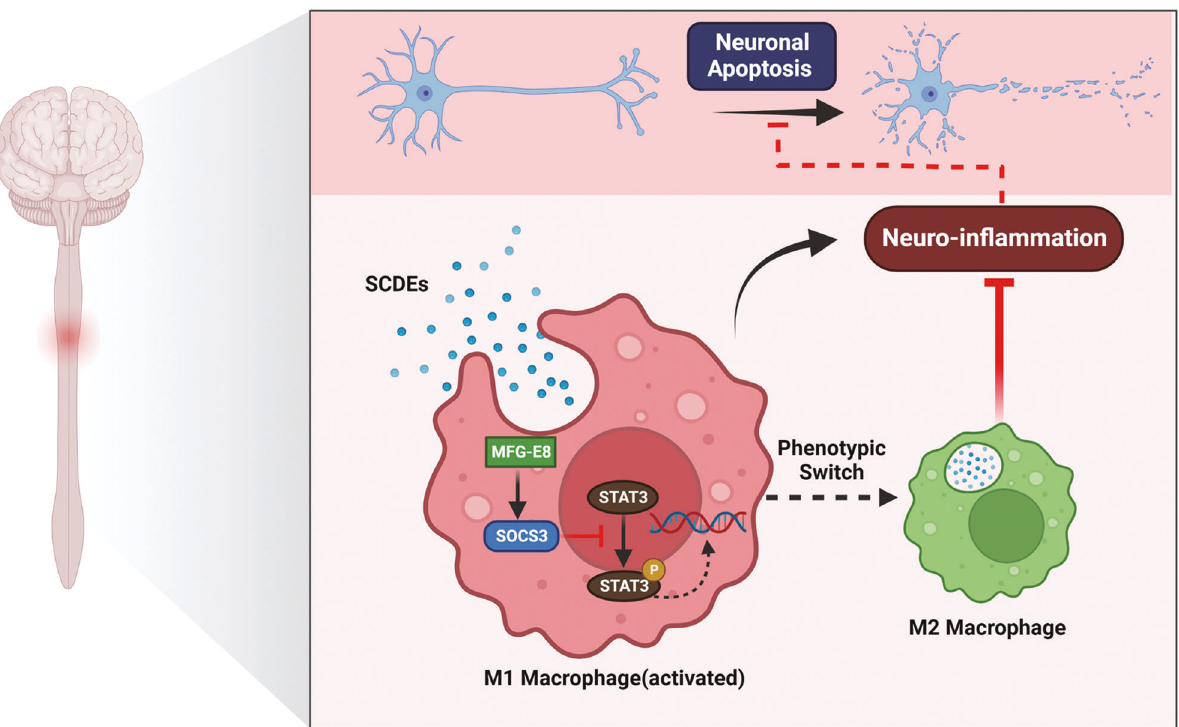
Fig. 10 The mechanism of SCDEs containing MFG-E8 modify macrophage/microglial polarization through SOCS3/STAT3 pathway after SCI. Spinal cord injury induced activation of STAT3 phosphorylation in macrophages/microglia, led to M1 polarization and exacerbated in fl ammatory damage at the site of spinal cord injury. After treatment with SCDEs, they were phagocytosed by macrophages/microglia at the injury site and began to release MFG-E8. This increased the protein levels of SOCS3, which inhibited the phosphorylation of STAT3 to promote the conversion of the macrophage/microglia phenotype to M2 for alleviating in fl ammatory damage. Moreover, the improved in fl ammatory microenvironment at the SCI site reduced neuronal apoptosis and promoted nerve